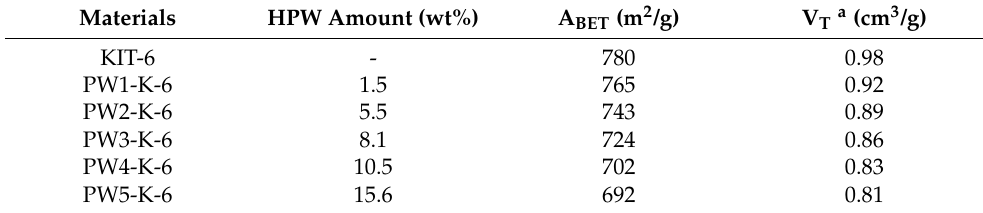
Figure 2 shows ATR-FTIR spectra of mesostructured silica (KIT-6), tungstophosphoric acid (HPW), and PW4-K-6. The heteropolyacid (HPW) displays